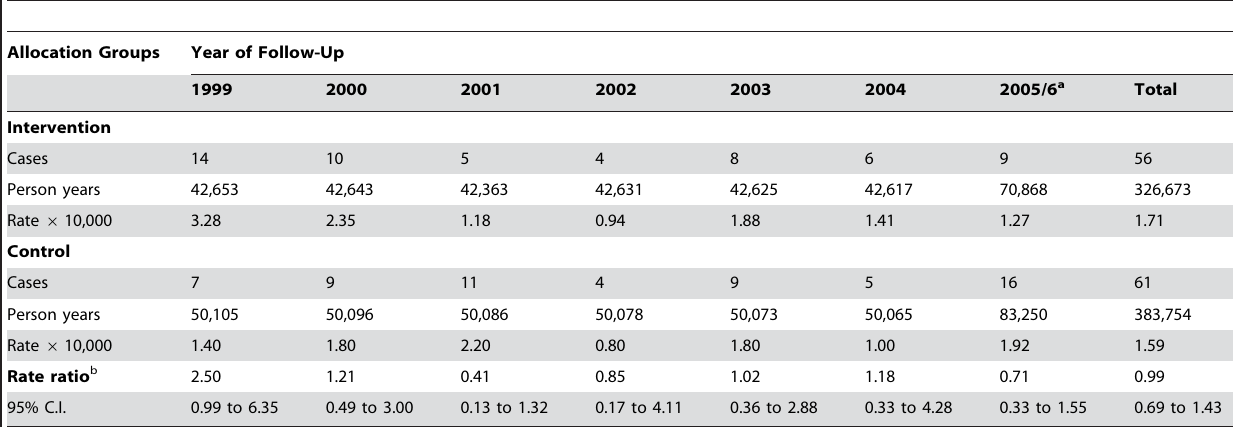
Table 2. Rates of leprosy separately for calendar year during the follow-up period among those with 1 BCG scar.